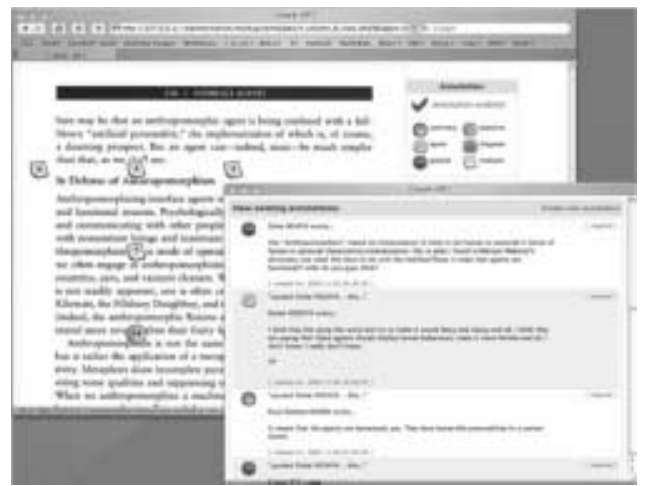
Figure 3. MarkUp, an online tool facilitating reading comprehension and shared